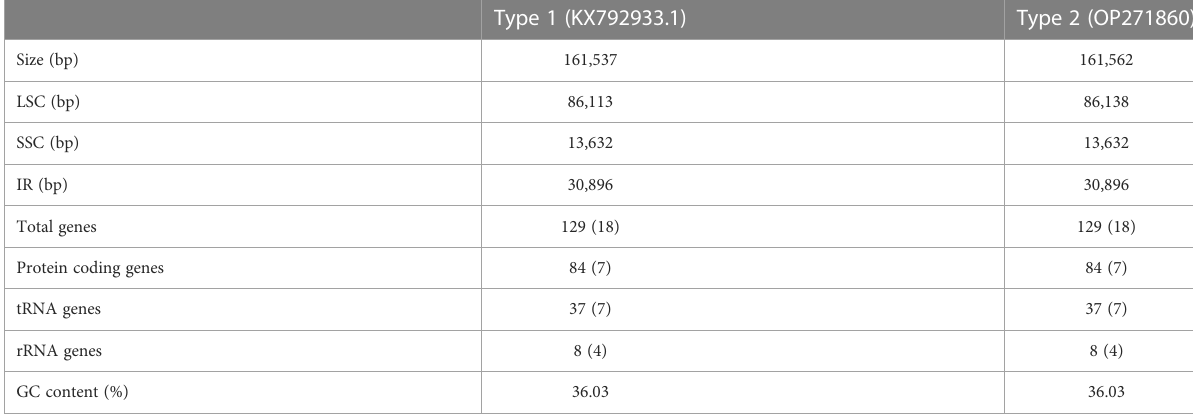
TABLE 1 Comparison of genomic features of the two types T. esculentum